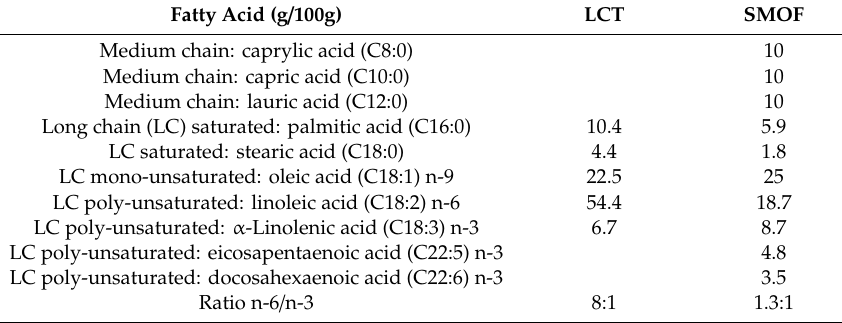
Table 1. Fatty acid compositions of both lipid emulsions tested in the